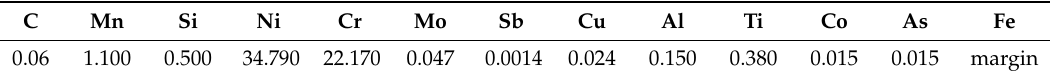
Table 1. Chemical composition of the alloy 800H (mass fraction, %).